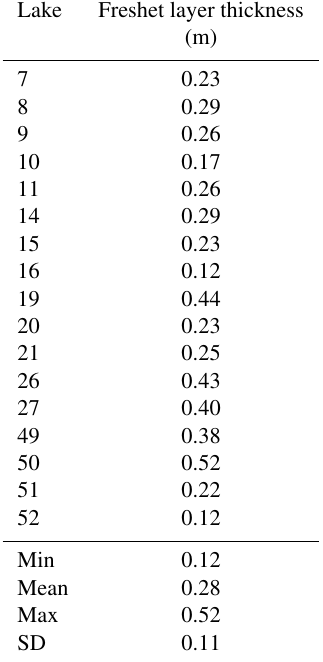
Table E1. Calculated layer thickness for each lake using Eq. (E1).